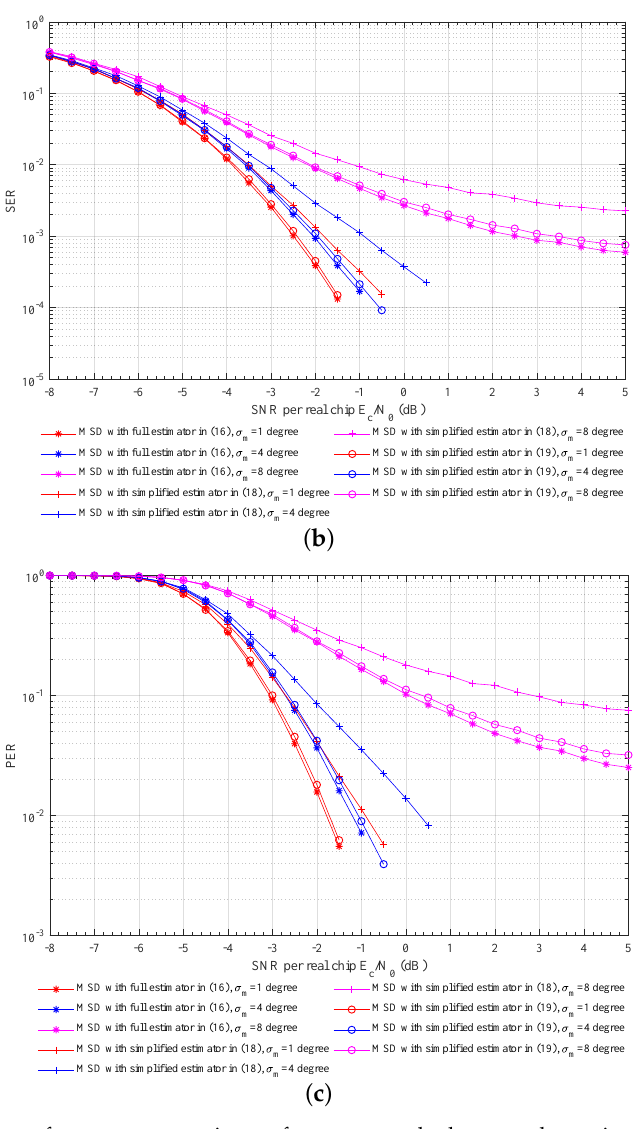
Figure 9. Detection performance comparisons of our proposed scheme under various estimators versus carrier phase offset (CPO) over a pure AWGN channel. ( a ) BER performance; ( b ) SER performance; ( c ) PER